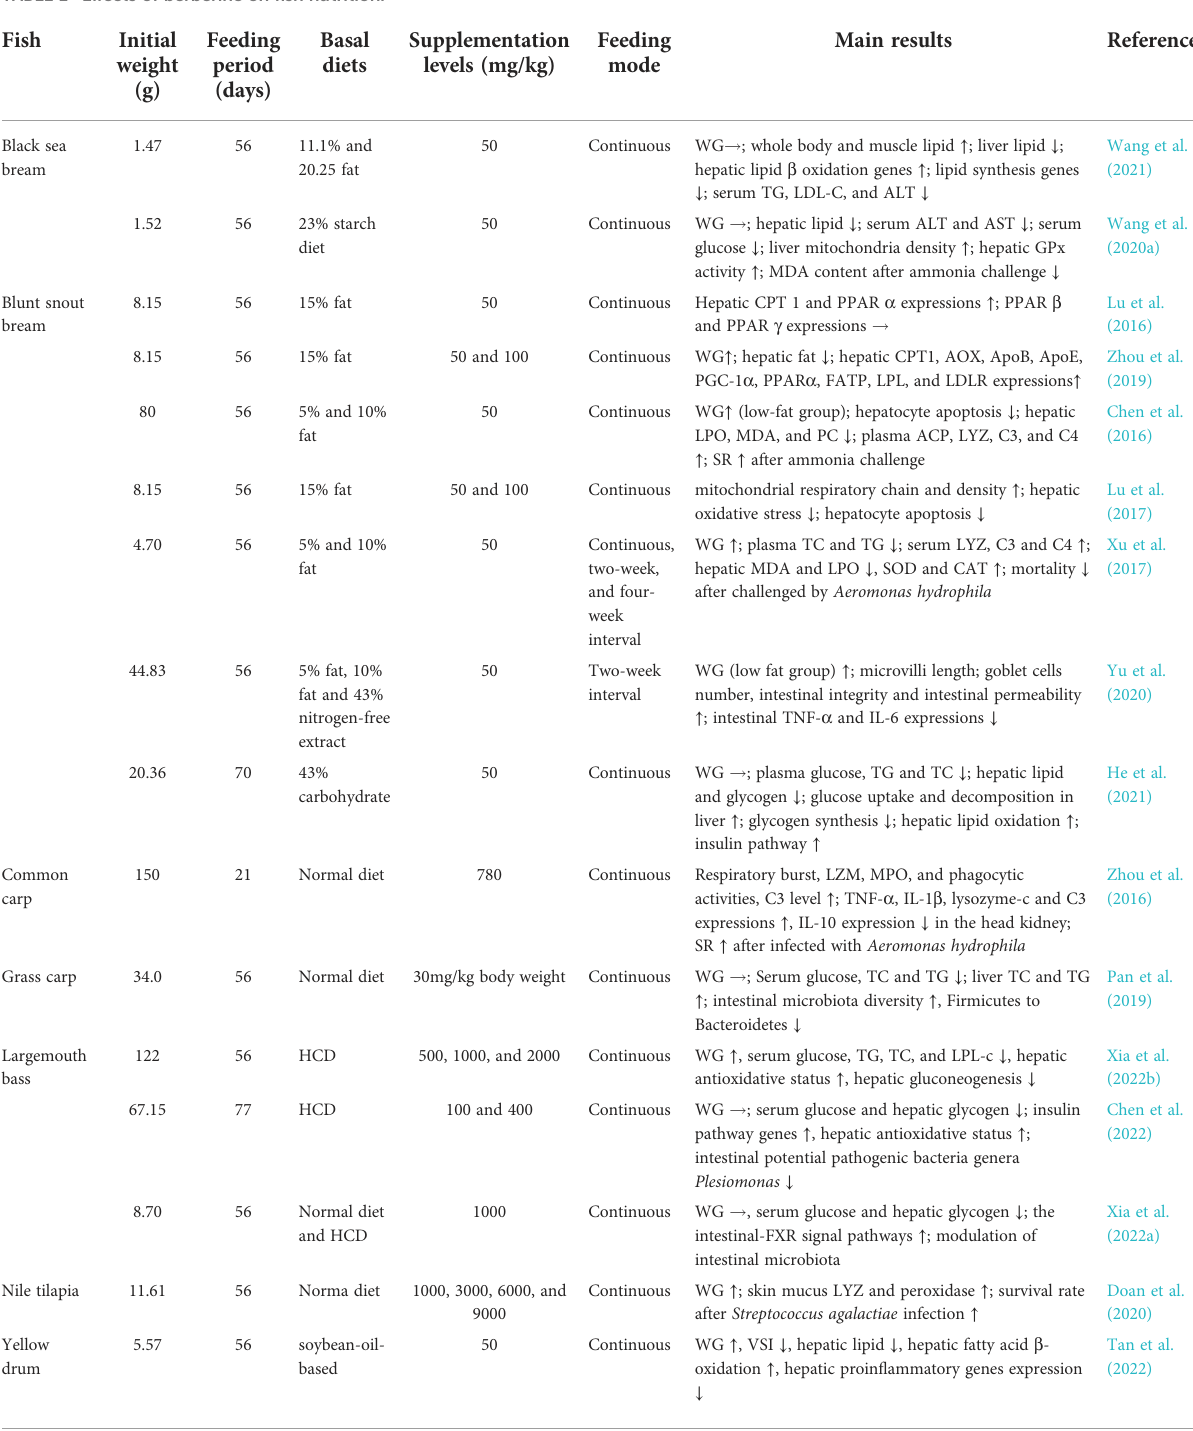
TABLE 1 Effects of berberine on fi sh